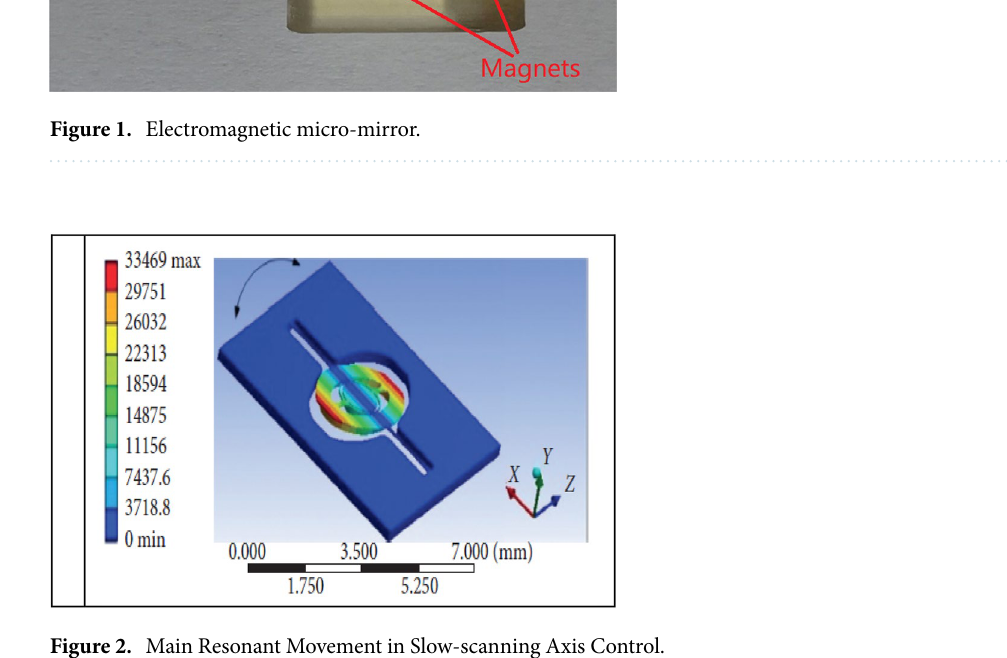
Figure 2. Main Resonant Movement in Slow-scanning Axis